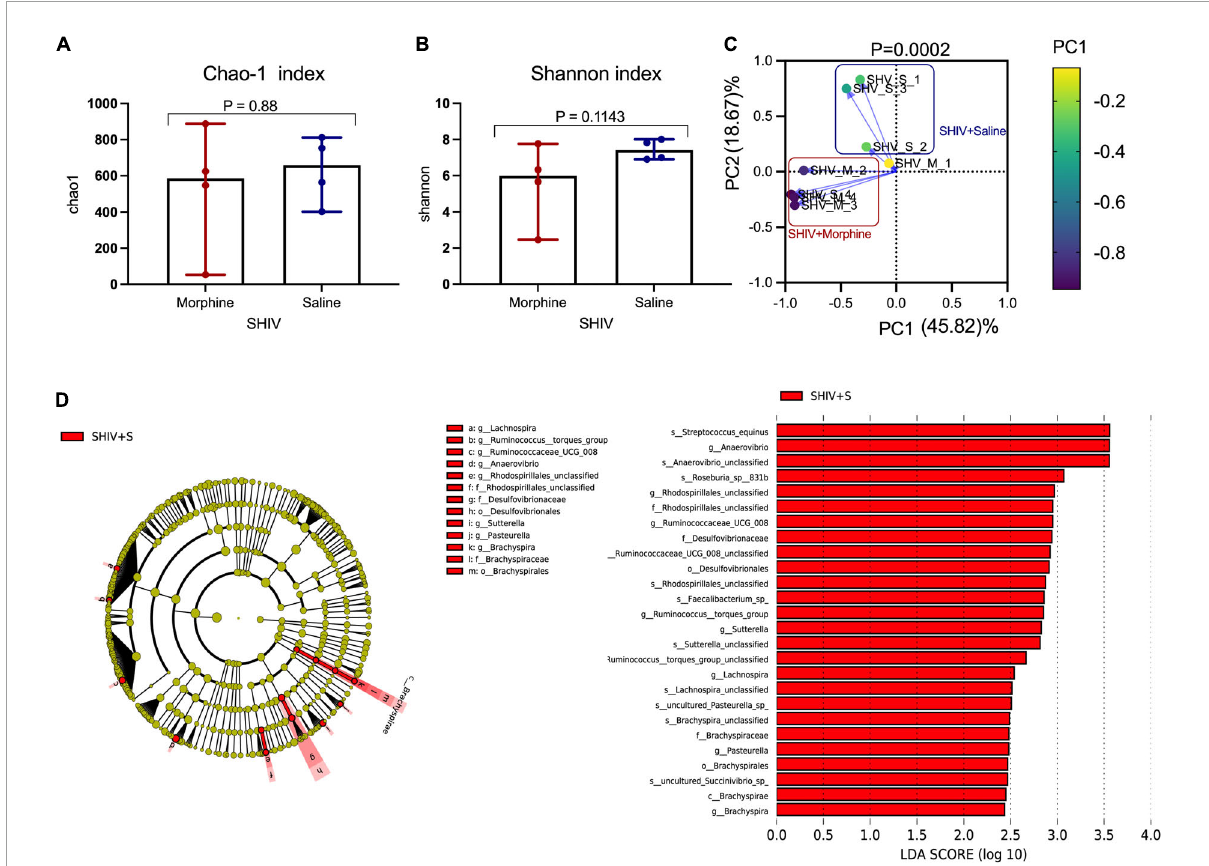
FIGURE5 Exposure to morphine disorientates gut microbiome homeostasis in simian human immunodeficiency virus (SHIV) infected rhesus macaques. Differences in (A) Chao-1 index (B) Shannon index as measures pf Alpha diversity in rhesus macaques exposed to either morphine or saline. Mann–Whitney U -tests were used to evaluate differences within the two groups in panels (A,B) . Data represent median ± range in panels (A,B) . (C) Weighted UniFrac Principal component analysis showing distinct clustering of SHIV + morphine animals vs. SHIV + saline animals. Variance was reported following the use of PCA in panel (C) . (D) Cladogram indicating significantly different taxa calculated using linear discriminant analysis effect size (LEfSe) analysis for microbiome discrimination at the community level (class, family, genus, and species) of SHIV + saline (red) vs. SHIV + morphine (blue) rhesus macaques. Side by side, corresponding tabulated linear discriminant analysis (LDA) are also presented with the logarithmic threshold score being set at 2.0. Using the Kruskal–Wallis and pairwise Wilcoxon tests, p < 0.05 set as cut-off for differences within the studied